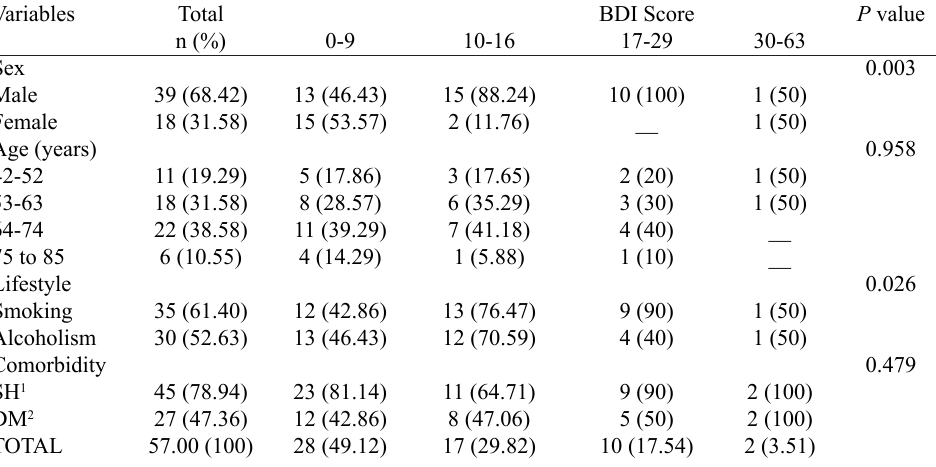
Table 3. Association through the Chi-Square between depressive symptoms, gender, age, lifestyle, and comorbidities. São Luís - MA,